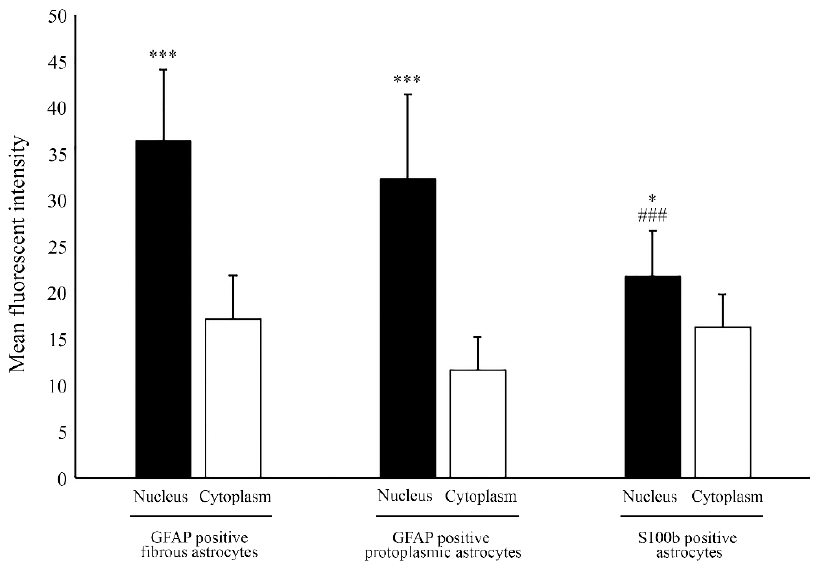
Figure 4. Quantitative analysis of aromatase localization in astrocytes. Analysis of mean fluorescent intensity revealed that Aro intensity is significantly stronger in the nucleus than in the cytoplasm in different astrocyte subtypes. GFAP-positive fibrous astrocytes showed stronger nuclear Aro intensity (36.36 ± 7.7; n = 25) than GFAP-positive protoplasmic astrocytes (32.25 ± 9.18; n = 29). Nuclear Aro intensity in the S100b-positive subtype (21.72 ± 4.98; n = 24) was significantly lower than in the GFAP-positive subtype. Data are presented in mean ± SD. * p <0.05, *** p < 0.001, ### p < 0.001. Asterisks indicate the significance between the nucleus and cytoplasm within each group. Pound (###) indicates the significantly lower intensity of nuclear Aro between GFAP and S100b positive astrocyte subtypes.